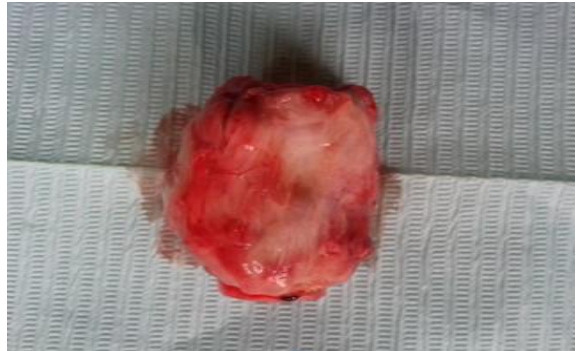
Figure, 5: Shows binding polypropylene mesh and bone cement with trachea of dog in G1 at 60 postoperative day.